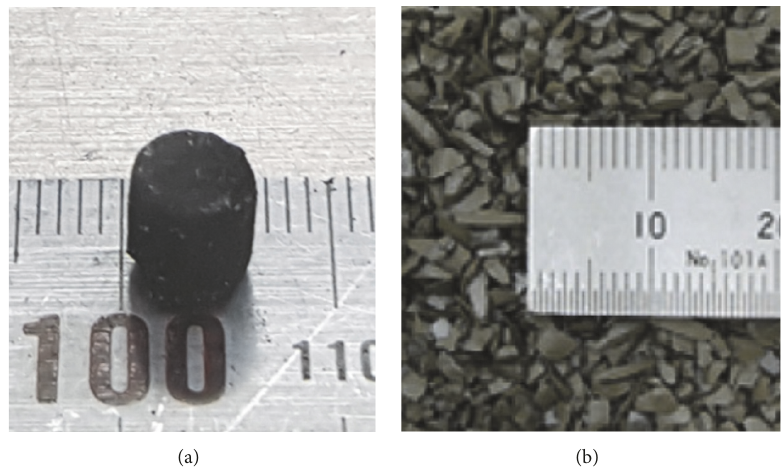
Figure 3: Images of the simfuel used in (a) the present study and (b) the previous study [29] (the minimum unit of the scale is 1mm).